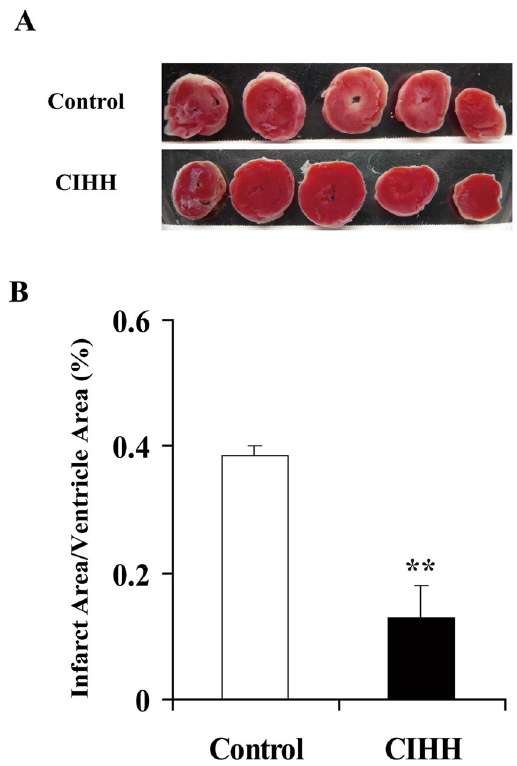
Figure 2. Effect of CIHH on the infarct size in isolated rat hearts. ( A ) Representative 2,3,5-Triphenyltetrazolium chloride (TTC) staining of heart slices after I/R. ( B ) Effect of CIHH on infarct size. All data were expressed as mean ± SD, n = 4 for each group. ** P < 0.01 vs control